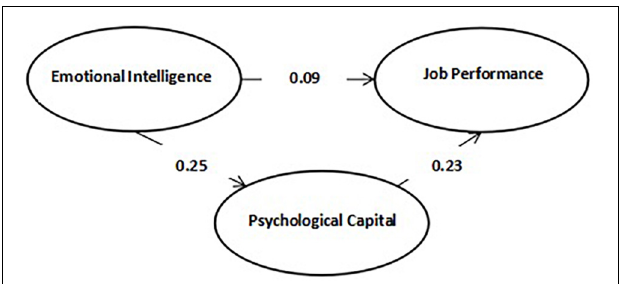
FIGURE 2 | Schematic diagram of the mediating effect of psychological capital in the influence of emotional intelligence on job